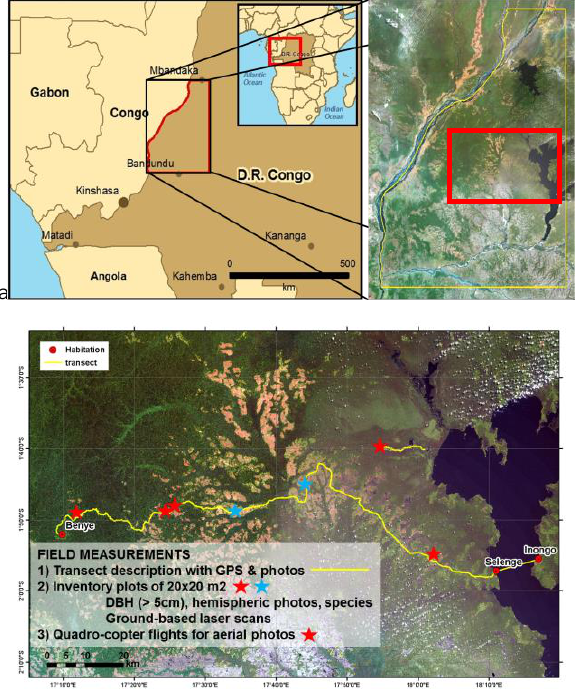
Figure 1: (a) ReCover service area in DRC of about ~68000 km2 bounded by Congo River (west), Lake Mai Ndombe 8º3 ’E), ci ies of Mb nd k º 3’N) nd B ndundu 3º 5’S). (b) Transect and forest plot sites of the fieldwork area (red rectangle in zoom of 1a).